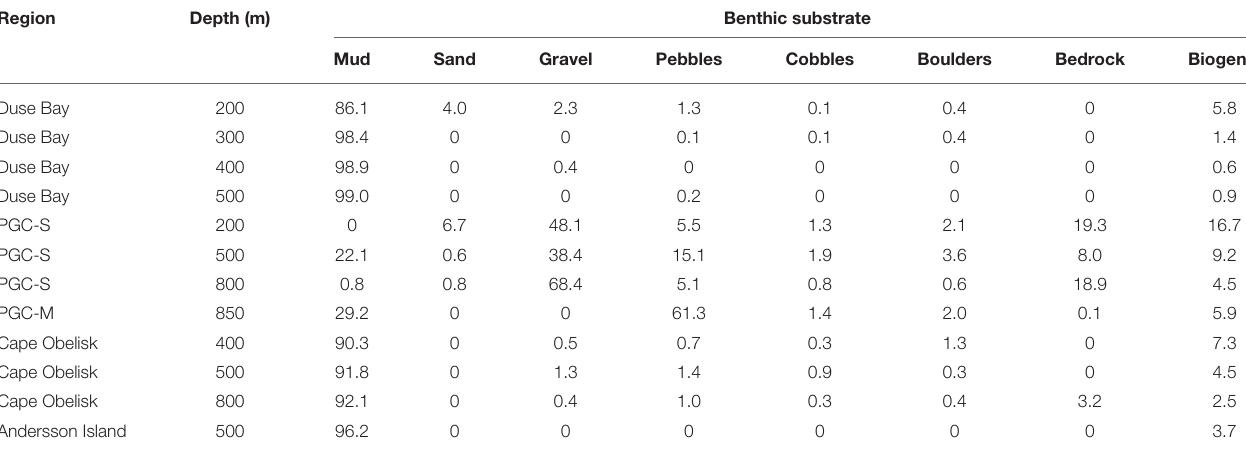
TABLE 2 | Mean % cover per photo of substrate size classifications by region/depth set. Region Depth (m) Benthic substrate Mud Sand Gravel Pebbles Cobbles Boulders Bedrock